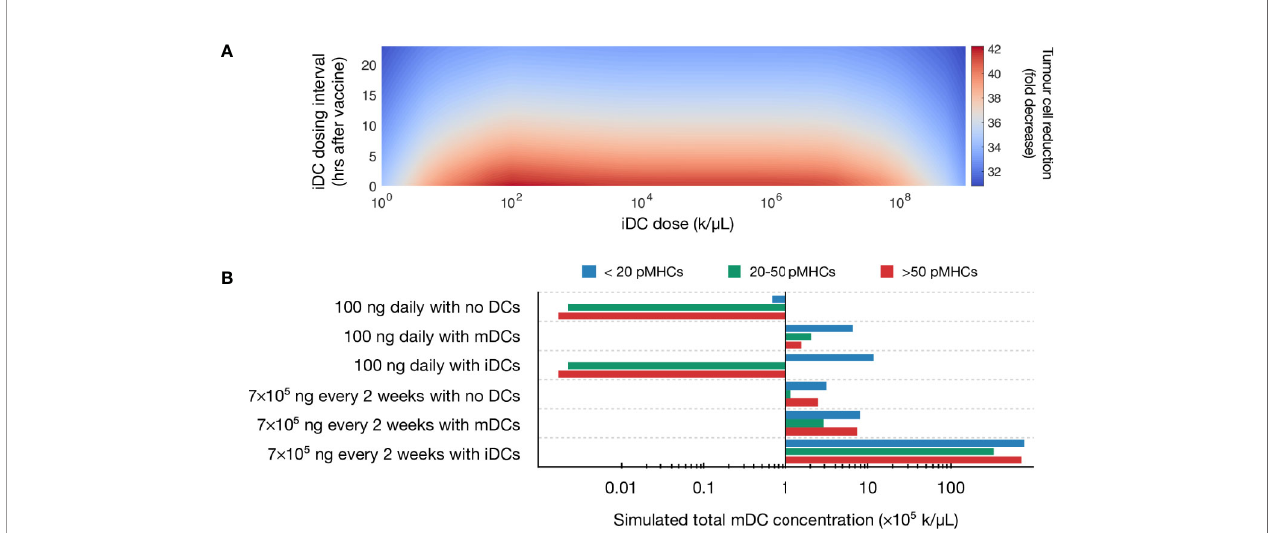
FIGURE 2 | Simulated induction of iDCs favors tumor reduction. (A) Heatmap depicts predicted tumor cell reduction (fold change) for different iDC dosages when given with 100 ng of peptide daily. Here, the unit ‘ k ’ denotes 10 3 cells. (B) Stacked bar chart visualizing the predicted distribution of antigen on mature DCs for various vaccine